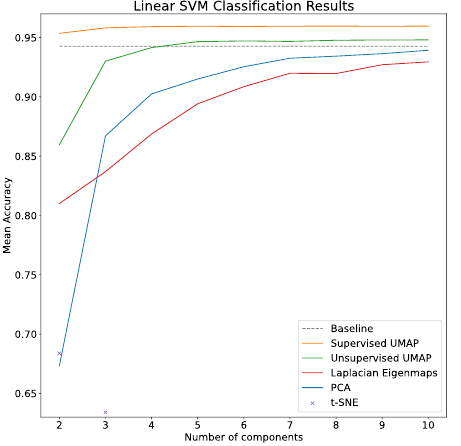
Figure 4. Mean accuracy for the SVM classification of embedded test data via UMAP, PCA, LE and t-SNE. Results are shown over increasing dimensions of embeddings.